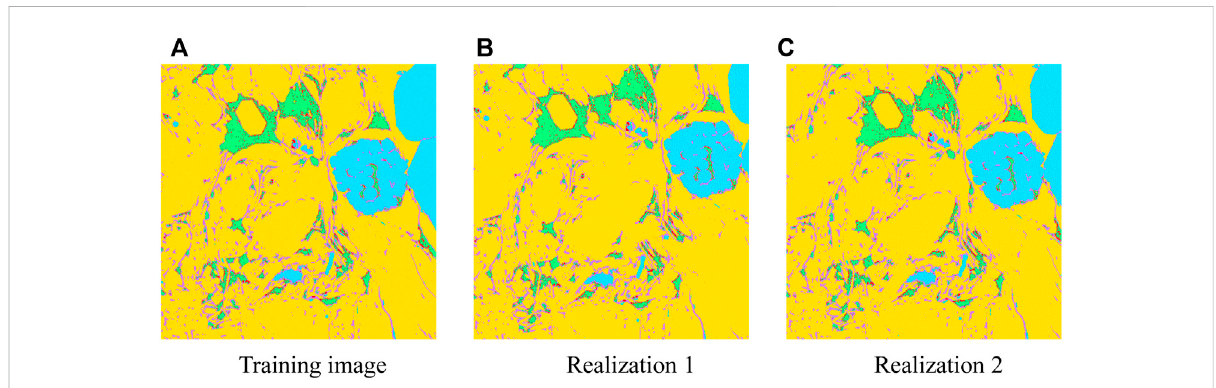
FIGURE 12 2D shale segmented digital rocks (A) training image, (B) and (C) are realizations 1 and 2, respectively, which are obtained by segmenting the reconstructed gray images. Red indicates the organic pore phase; green indicates the organic matter phase, purple indicates the inorganic pore phase, yellow indicates the matrix, and light blue indicates the pyrite